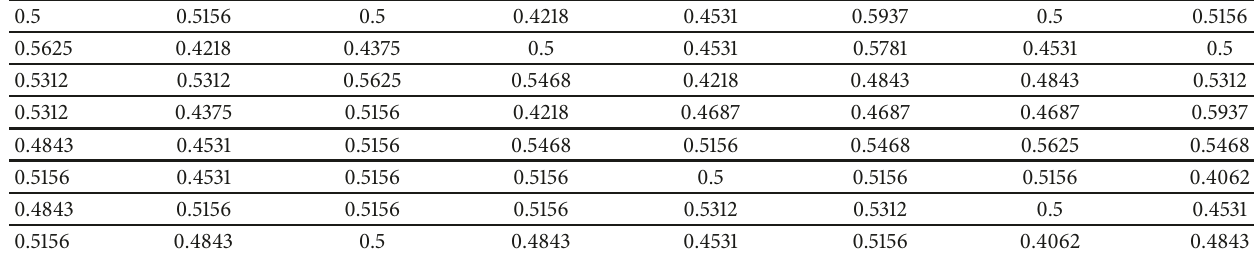
Table 10: Dependency matrix for SAC of the proposed 8 × 8 S-box.